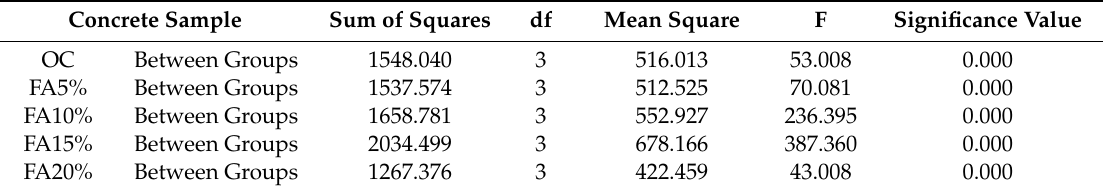
Table 6. ANOVA table for compressive strength of concrete samples at di ff erent temperatures.